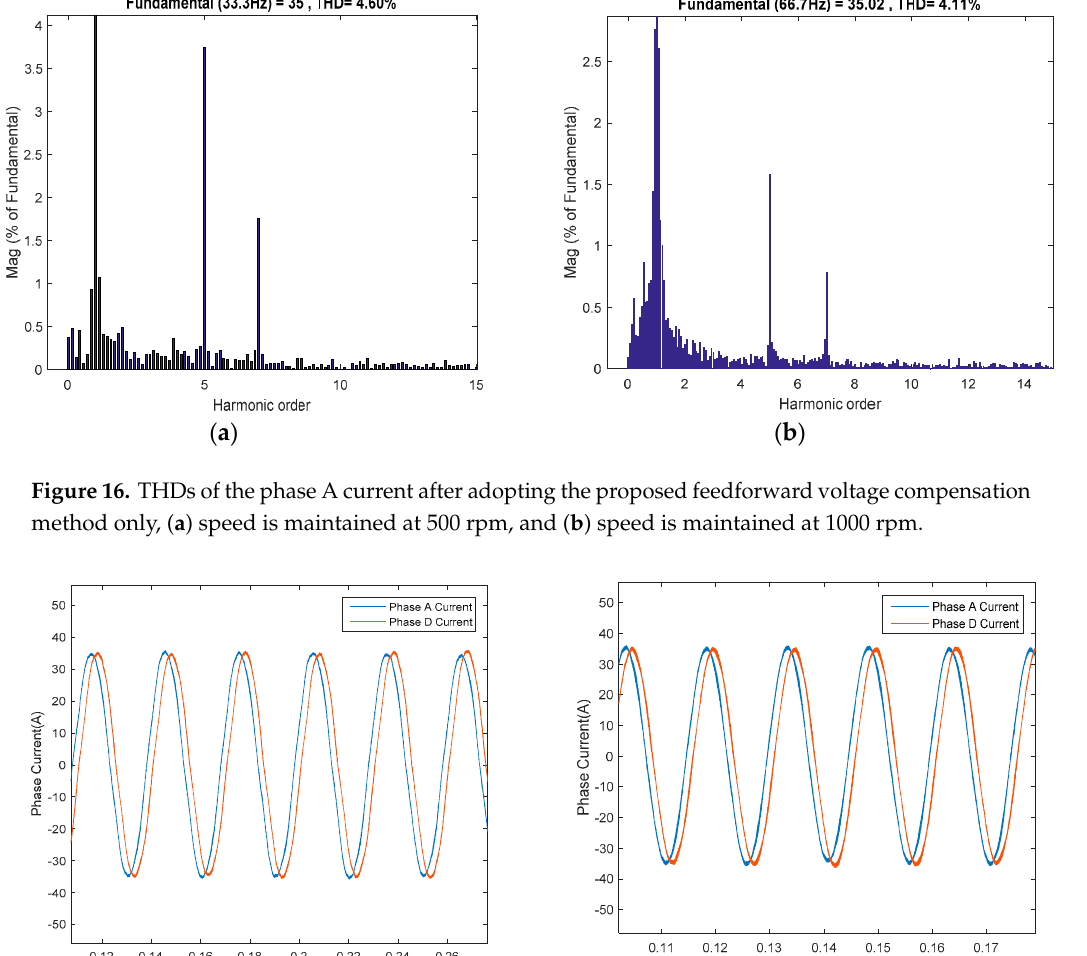
( b ) Figure 18. THDs of the phase A current after adopting the proposed resonant controller only, ( a ) speed is maintained at 500 rpm, and ( b ) speed is maintained at 1000 rpm. Figure 19 depicts the experimental results after adopting both the proposed feedforward voltage compensation and resonant controller, which is equivalent to Case 4. The reference voltages are synthesized based on the proposed SVPWM method illustrated in Section 5. The waveforms of phase currents have been improved a lot, while the fifth and seventh current harmonics are significantly reduced. The THDs of the phase A current are reduced to 2.97% and 2.65% respectively with the proposed combination method, as shown in Figure 20. The THDs are the smallest among the four above-mentioned cases.